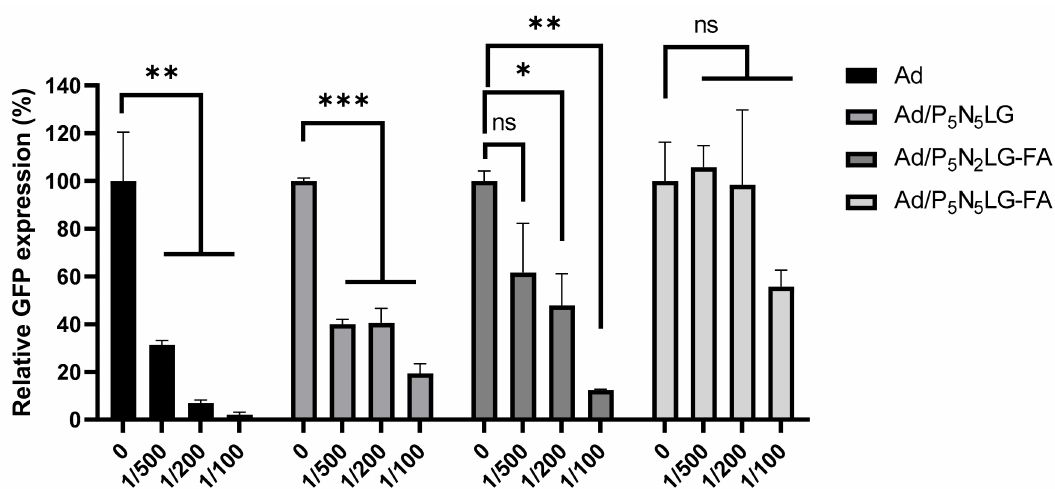
Figure 6. Neutralizing antibody assay in vitro. KB cells were treated with Ad or Ad nanocomplexes pre-treated with Ad-specific neutralizing Ab (100MOI) for 48 h at 37 ◦ C. The degree of GFP expression was then observed and analyzed by Incucyte Zoom live cell analysis system (Essen Bio-Science, Ann Arbor, MI, USA). The data are representatives of duplicate samples. Bars represent mean ± SD. * p < 0.05, ** p < 0.01, *** p <